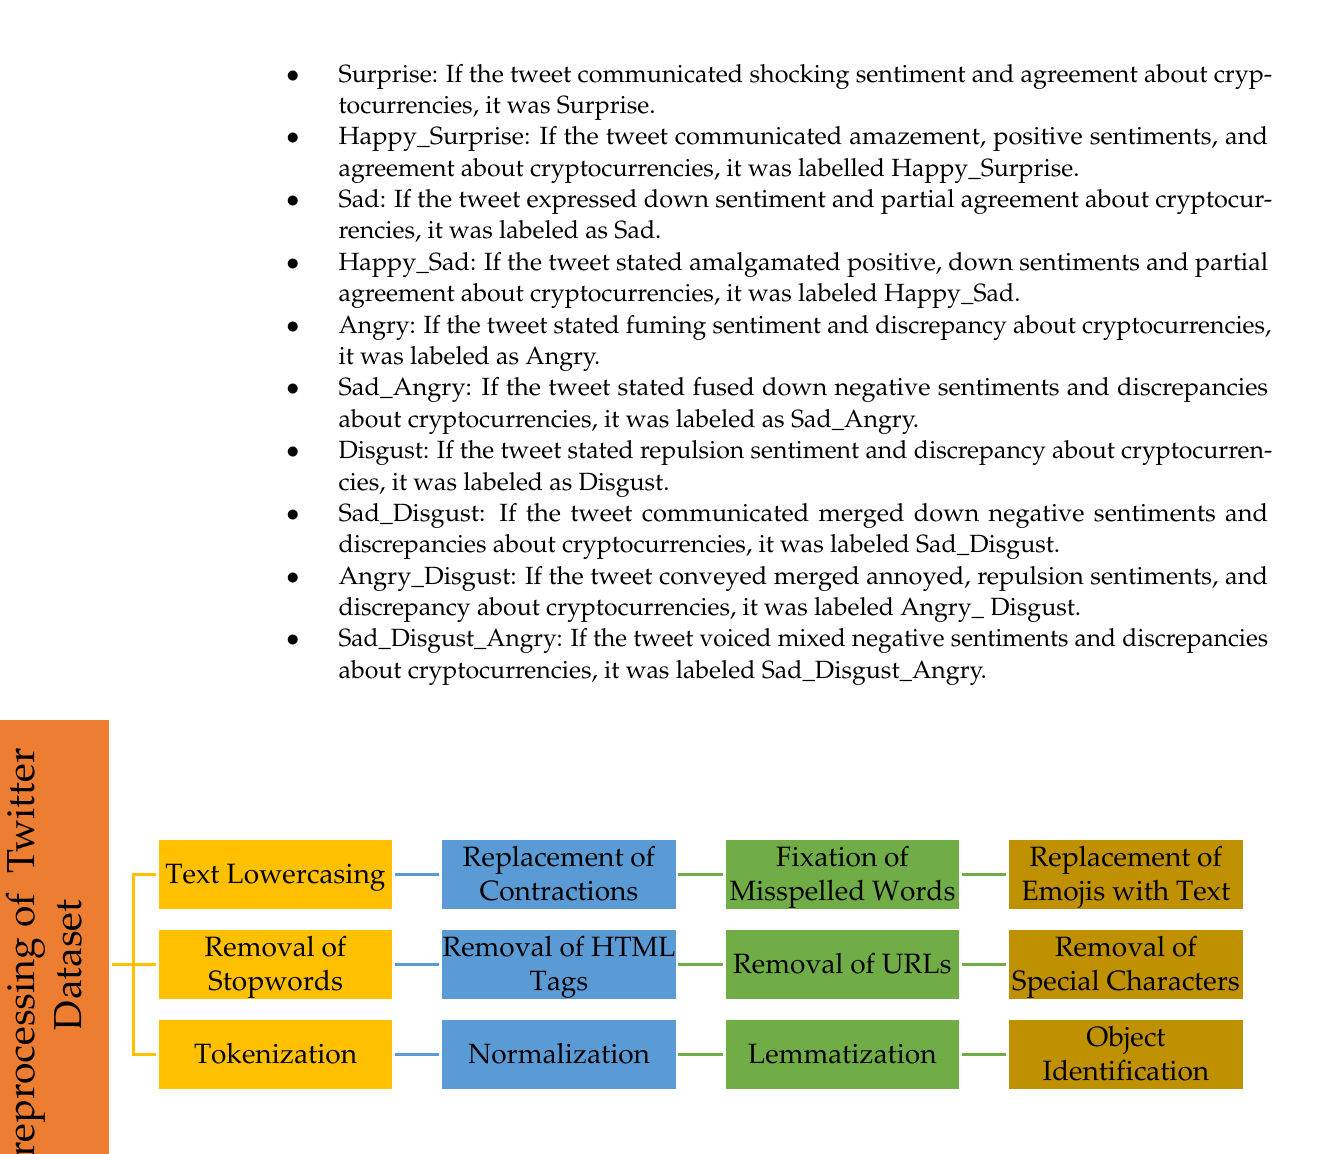
Figure 3. Tweets Figure 3. Tweets preprocessing.